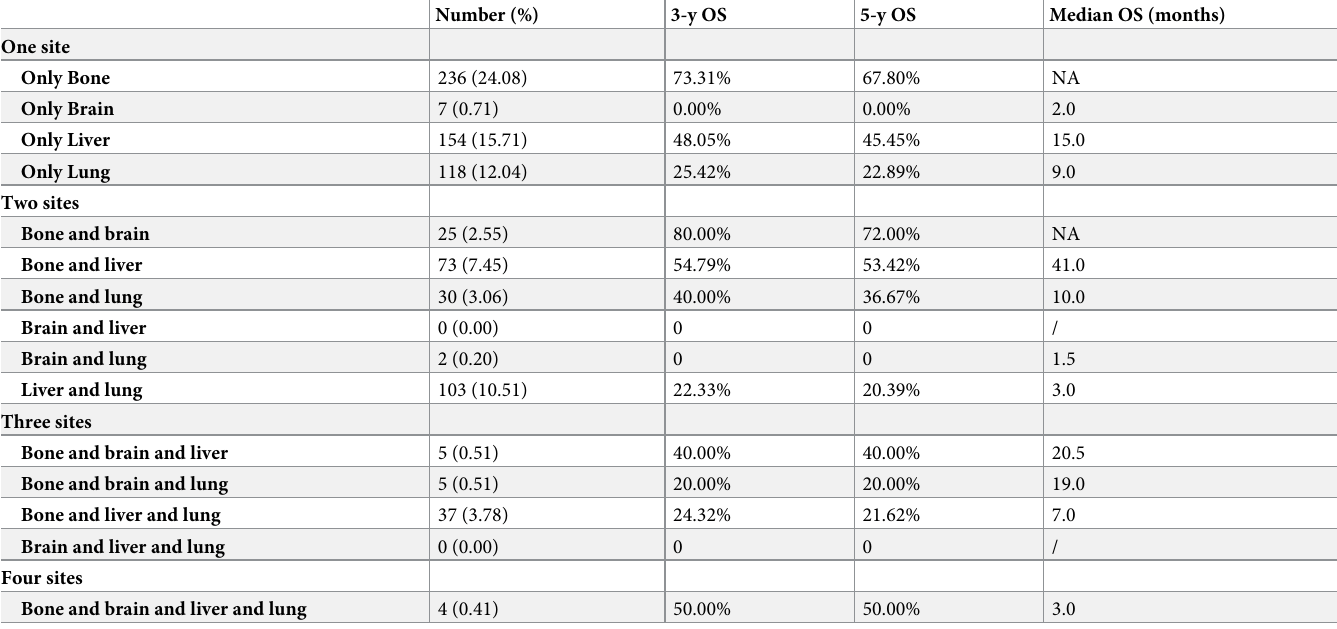
ability (Fig 4). We could predict the 1, 3, and 5 year survival probability in the base of the sum of the dot scale at the top and the points for every factor. The probabilities of 1, 3, and 5 year survival relied on the fractional proportion present at the bottom of the nomogram. The C- Table 3. Frequencies of combination metastasis and 3, 5-y